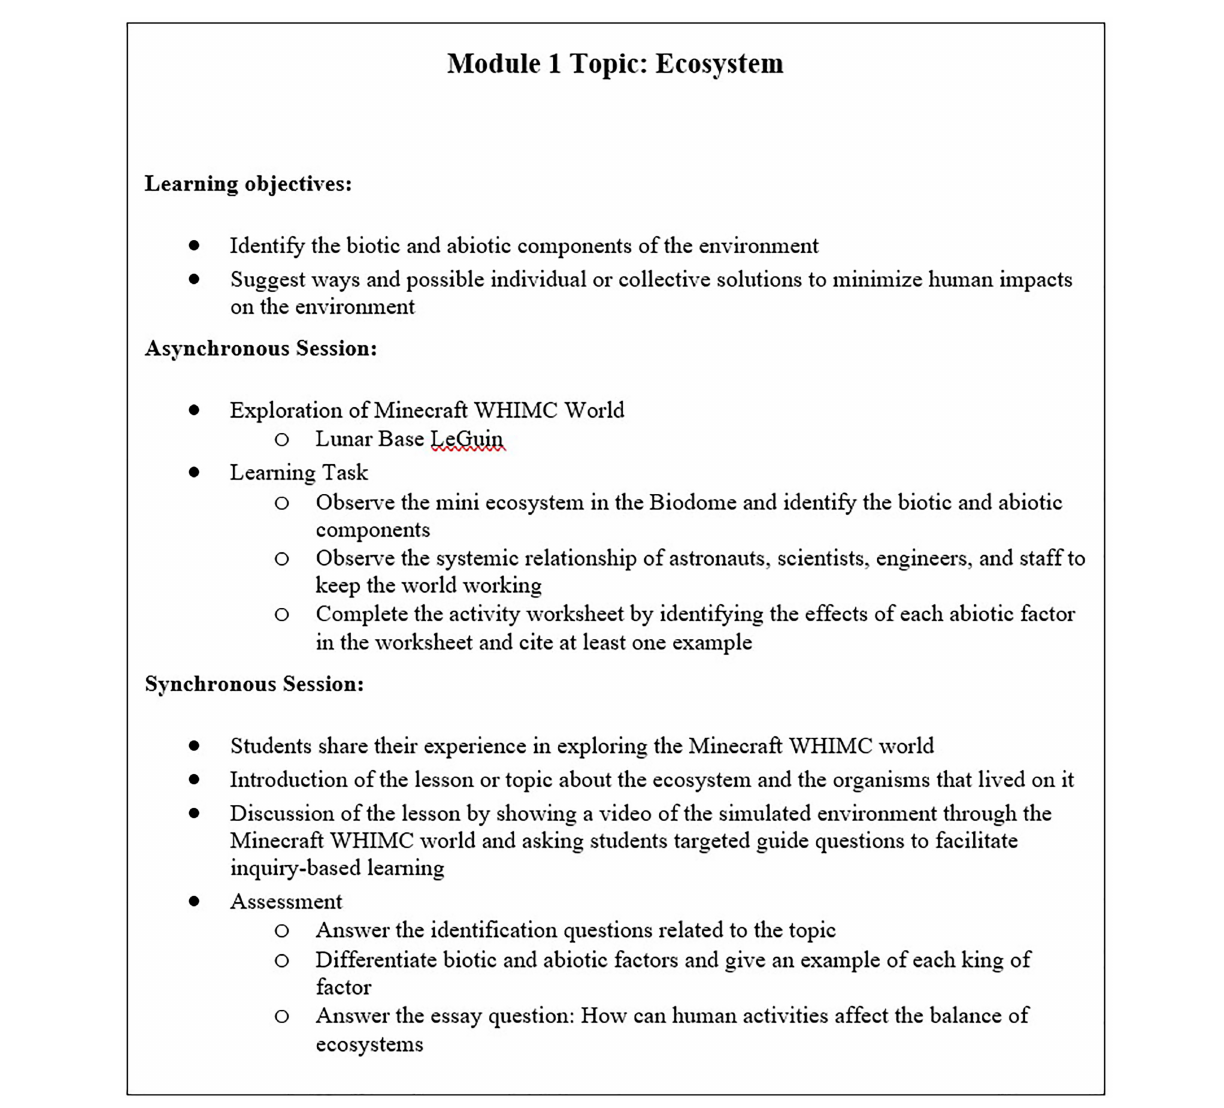
FIGURE 2 Lesson excerpt of module